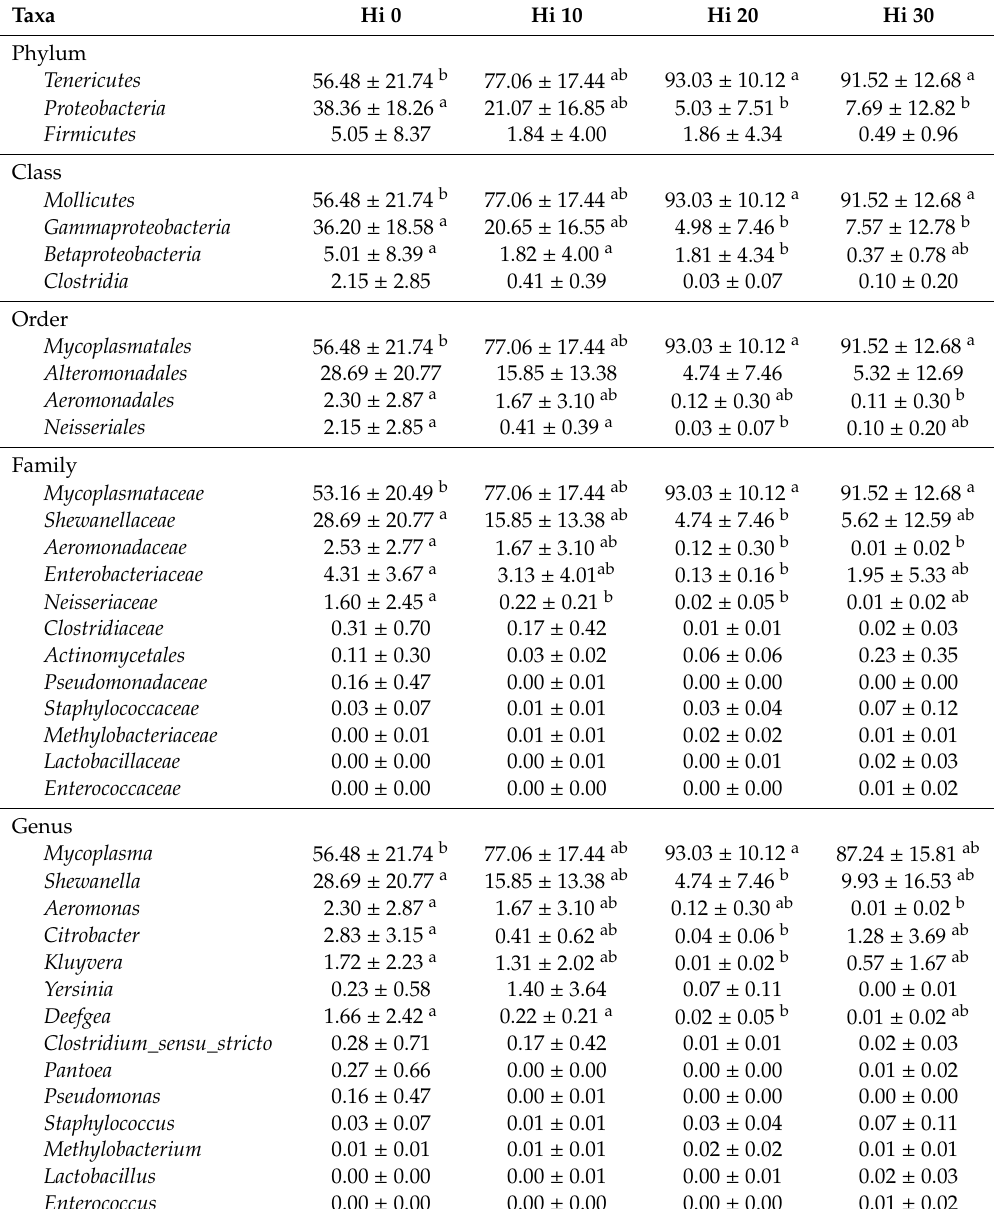
Table 4. Mean relative abundance (%) ± SD of the most prevalent phyla, orders, classes, families, and genera found in mucosa samples of rainbow trout fed with four experimental diets. Means in the same row with di ff erent letters indicate statistical significance between taxonomic groups’ abundances ( p <